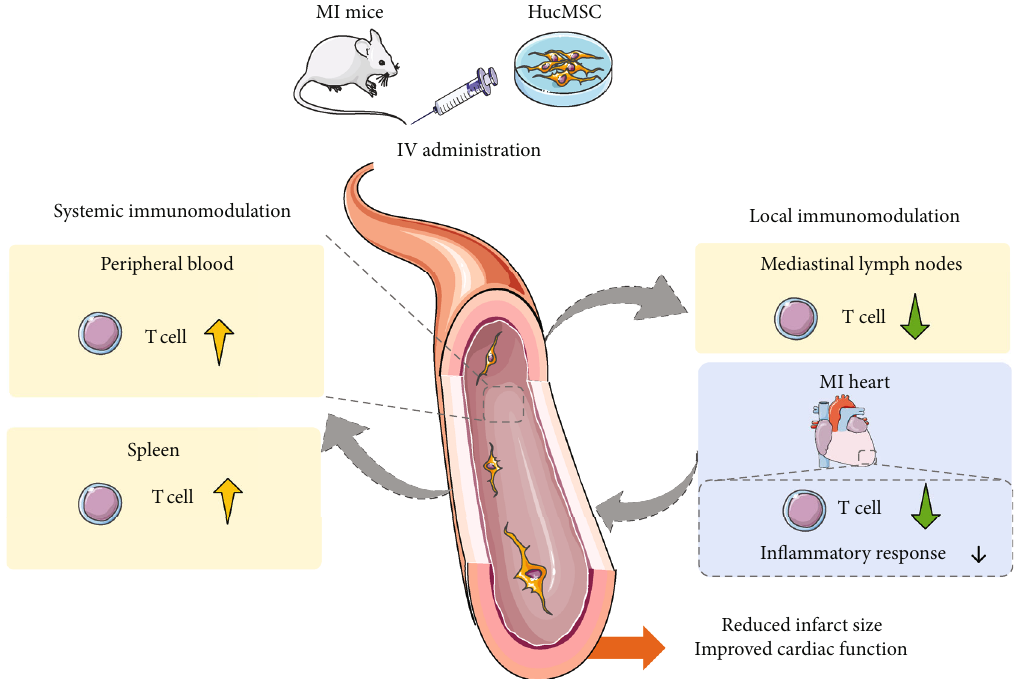
Figure 6: Schematic diagram. Iv-administered HucMSC attenuated cardiac function deterioration after infarction via systemic and local immune modulatory e ff